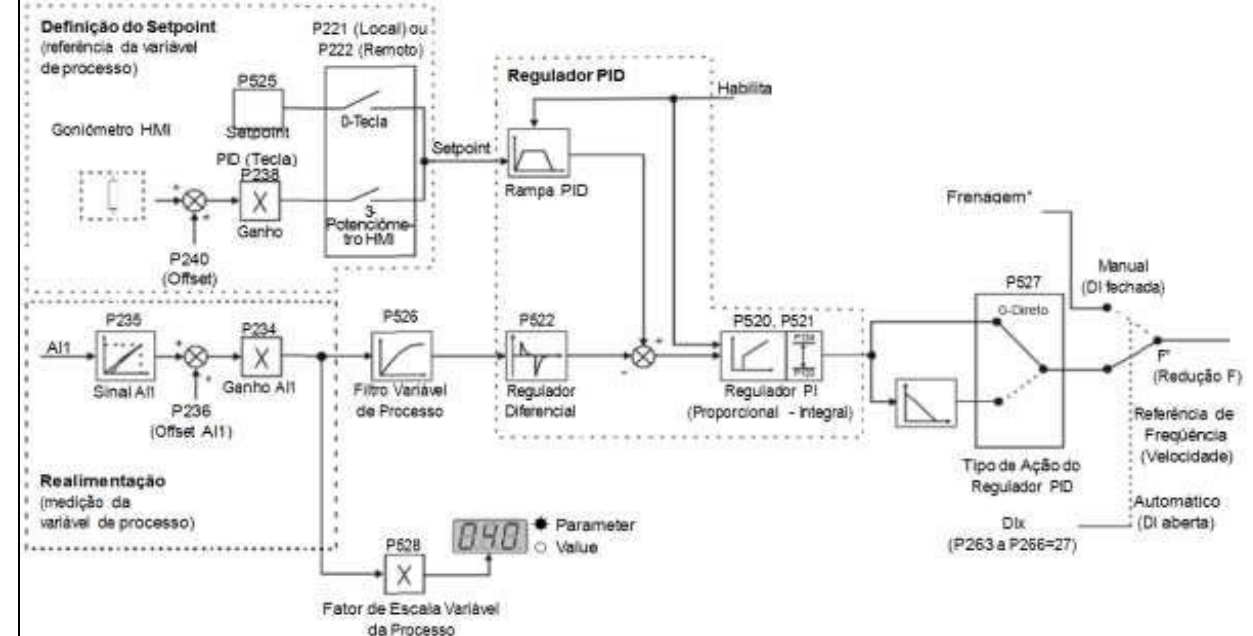
Figure 2: Inverter PID regulator